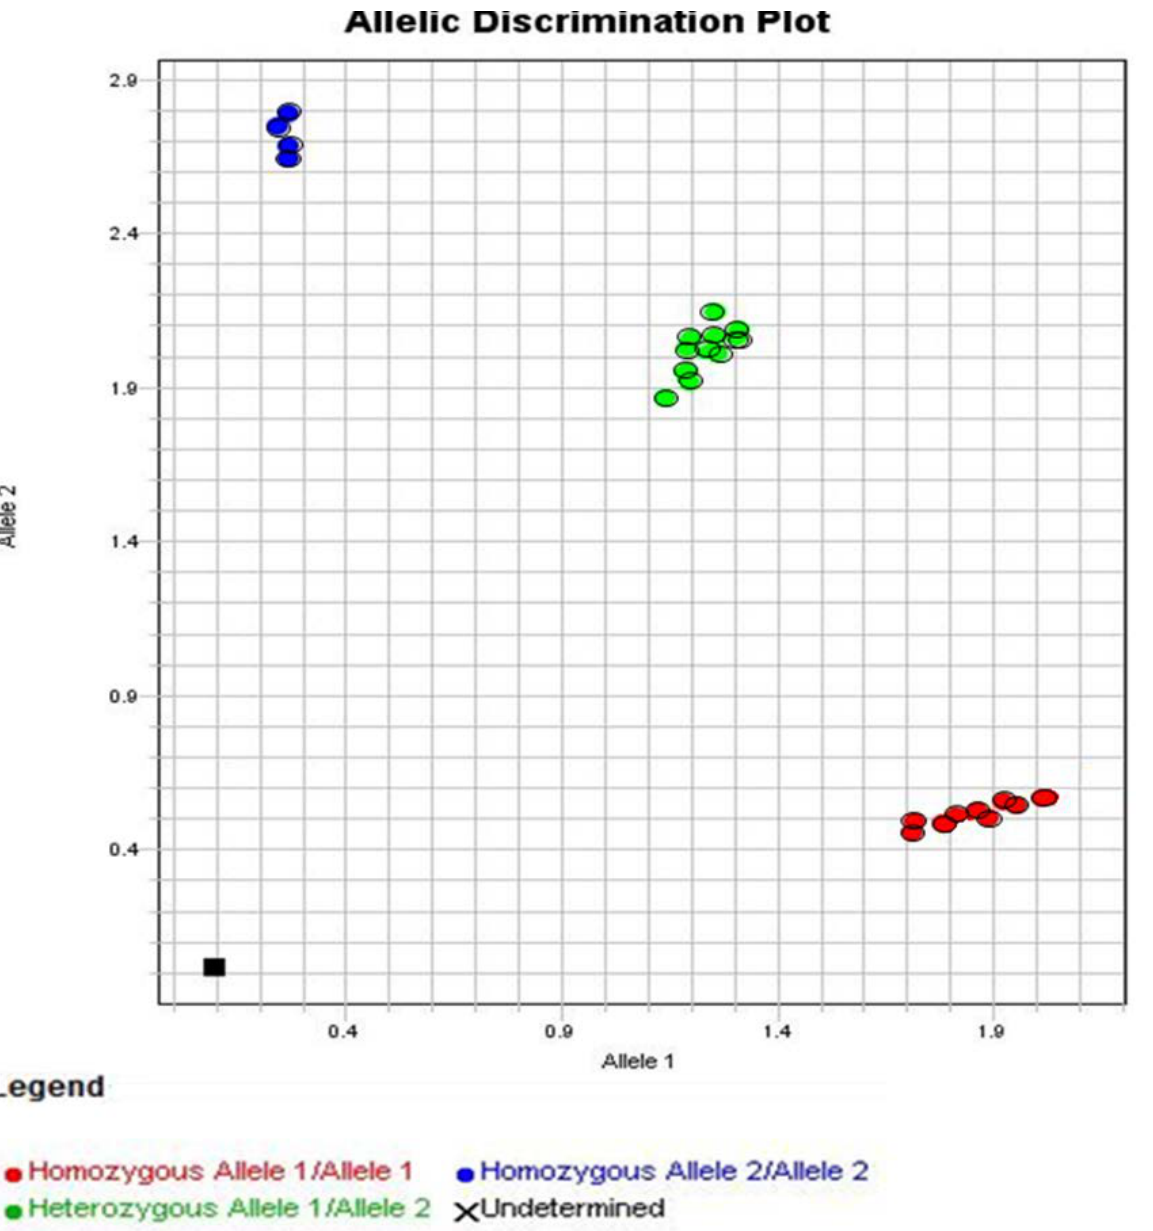
Figure 4. Representative graphic of allelic discrimination obtained after the genotyping assay for polymorphism in the il28b gene (rs12979860) in the older adults who participated in the study. In red color are presented the volunteers homozygous for allele 1, which corresponds to the nitrogenous base cytosine. In blue are presented the volunteers homozygous for allele 2, corresponding to the nitrogenous base thymine. In green are presented the heterozygous volunteers.